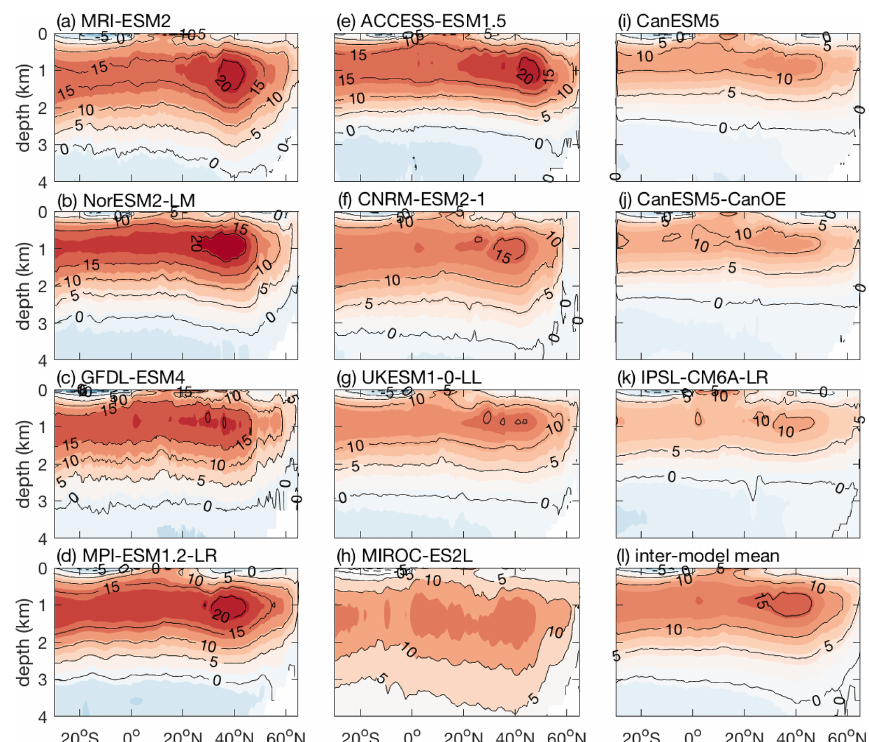
Figure 8. The Atlantic Meridional Overturning Circulation (AMOC; in Sv), in the pre-industrial era: (a–k) 11 CMIP6 Earth system models and (l) their inter-model mean. The estimates are based on pre-industrial control simulation (piControl) for years 121 to